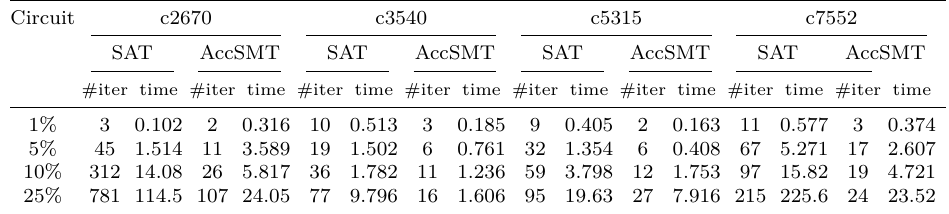
Table 6: Comparing the Execution Time and the Number of Iterations of the Accelerated Lazy SMT Attack (AccSMT) (Attack Mode 4) with that of Original SAT Attack (based on Lingling solver) in [SRM15] on ISCAS-85 Obfuscated Circuits using RLL[RKM10] Obfuscation Policy. Circuit